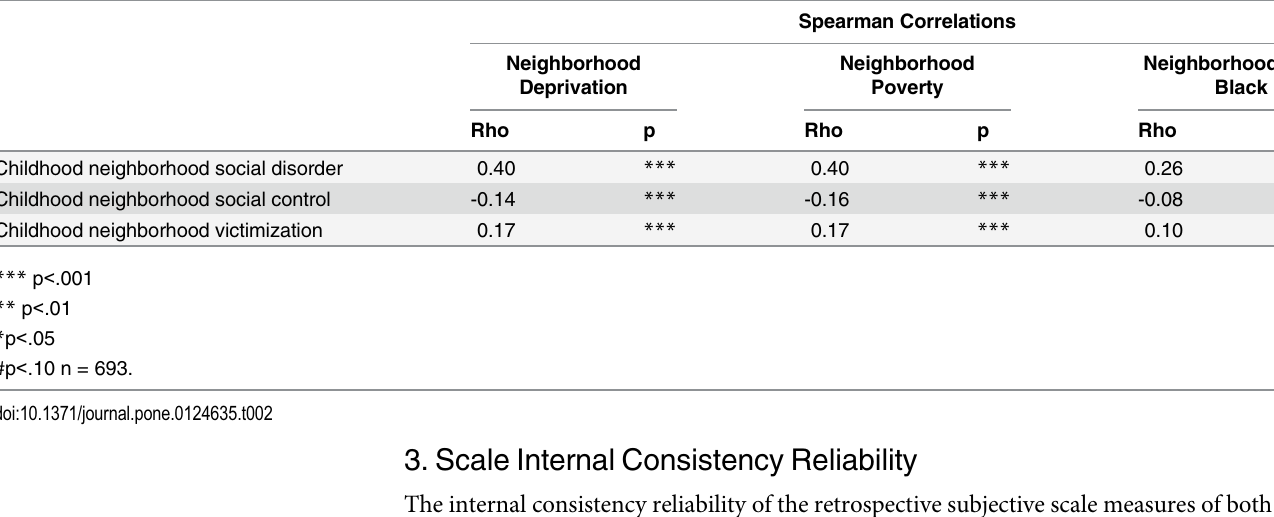
Table 2. Objective-Subjective Childhood (age 10) Neighborhood Correlations at Age 10, LIFE Study.